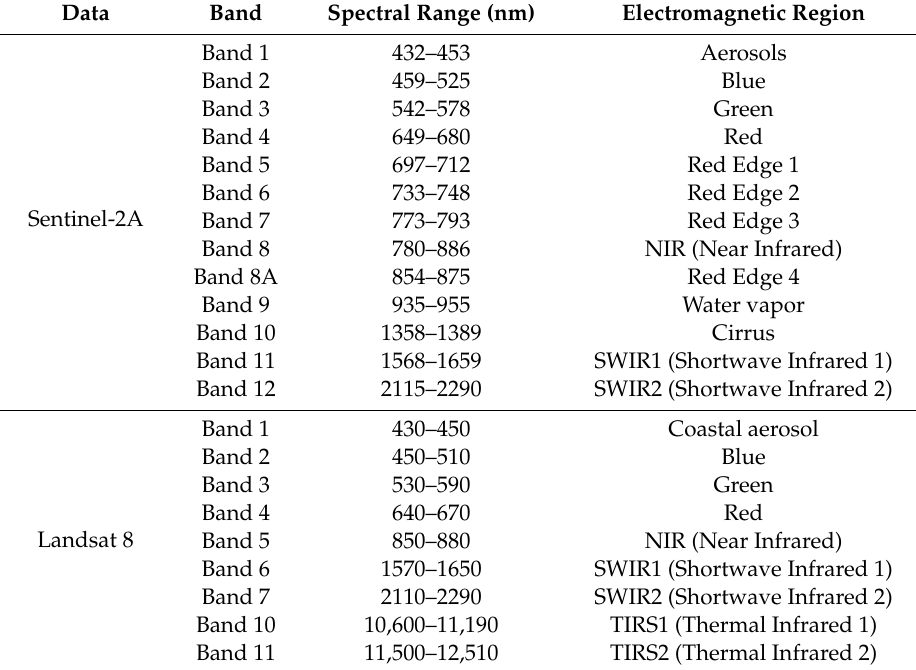
Table 1. Spectral bands of Sentinel-2A [77] and Landsat 8 [78] used in this